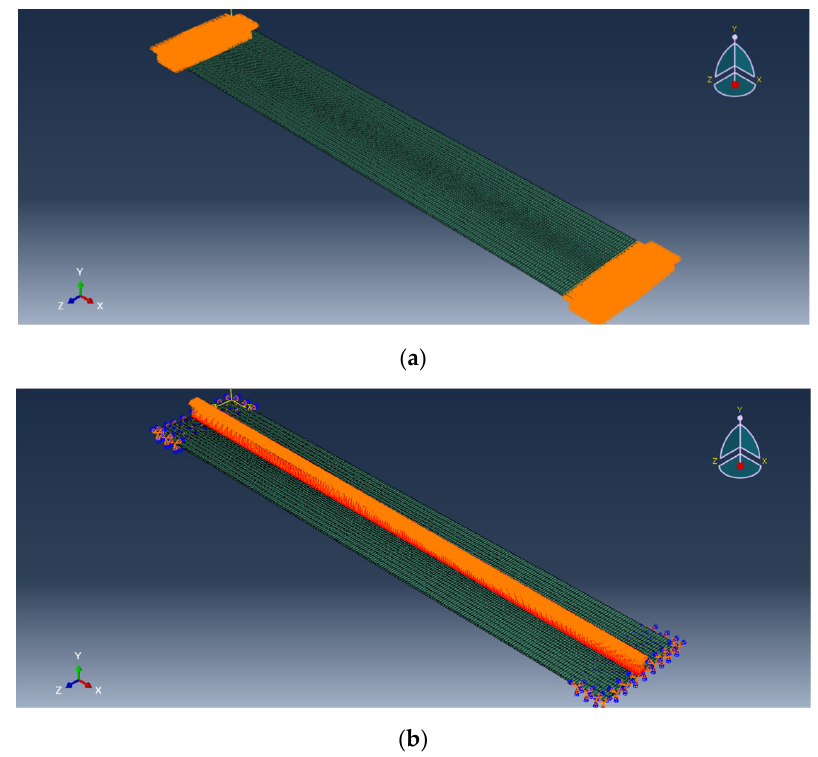
Figure 5. Fixed-beam model. ( a ) The boundary conditions. ( b ) The load conditions.